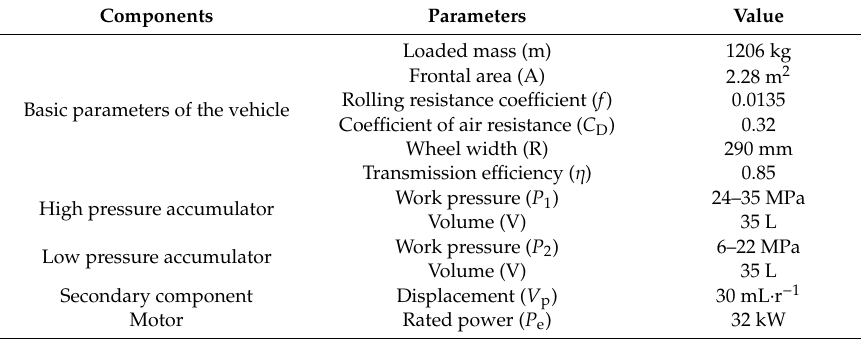
Table 3. Basic parameters of the MEH-DCDS.